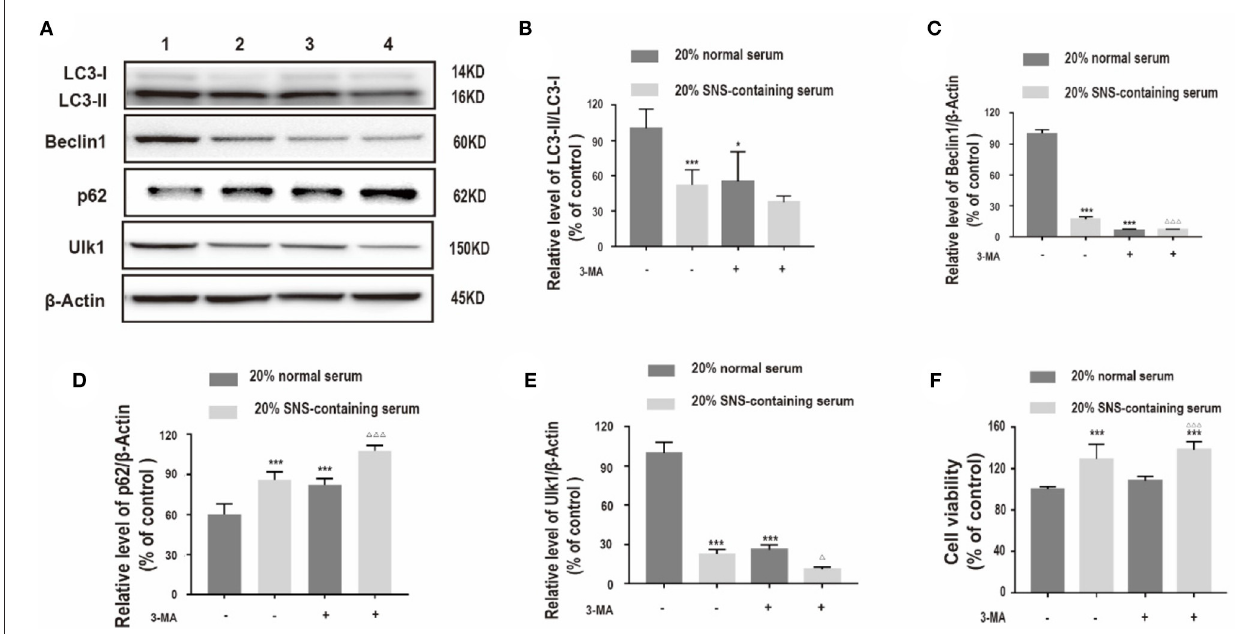
FIGURE 4 | (A–E) Western blot and quantitative analyses of LC3II/LC3I ratio, and Beclin1, p62 and ULK1 protein expression levels. 1: 20% normal serum + corticosterone group; 2: 20% SNS-containing serum + corticosterone group; 3: 20% normal serum + corticosterone + 3-MA group; 4: 20% SNS-containing serum + 3-MA + corticosterone group. ( n = 3). Each column represents mean ± SD. * P < 0.05, *** P < 0.01 vs. 20% normal serum + corticosterone group; 1 P < 0.05, 111 P < 0.01 vs. 20% SNS-containing serum group. (F) cells were incubated with 200 µ M corticosterone, 1mM 3-MA, and 20% serum for 24h. CCK-8 assay was used to determine cell viability. *** P < 0.01 vs. 20% normal serum group, 111 P < 0.01 vs. 20% normal serum + 3-MA group ( n = 4).